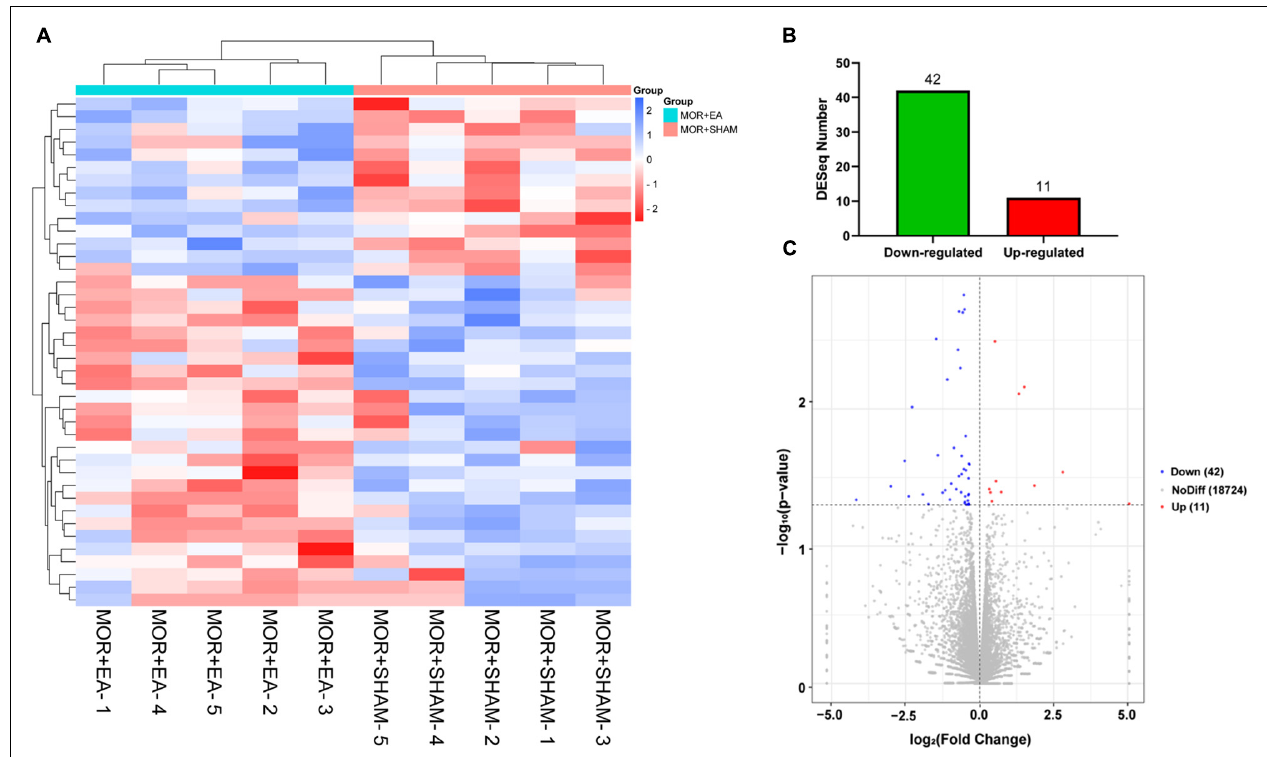
FIGURE 3 | Differential expression of genes. (A,B) Heat map of differentially expressed genes regulated by morphine or EA. Each row represents one differentially expressed gene; each column represents one sample. The dendrogram on the left reveals the gene clustering. Green and red spectrum colors indicating downregulated and upregulated expression, respectively. (C) Volcano plot. X -axis: log 2 (fold change); Y -axis: log 1 0(P-value). The red points represent gene that were significantly up-regulated; the blue points represent gene that were significantly down-regulated. EA,